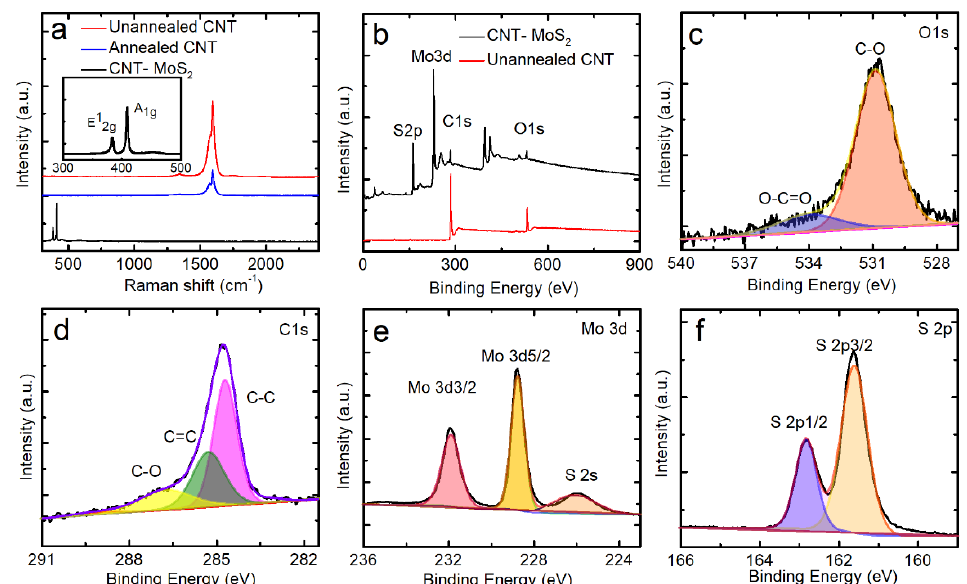
Figure 2. ( a ) Raman patterns of the unannealed and annealed CNT networks and CNT–MoS 2 composite network. ( b ) XPS survey of the unannealed CNT network and CNT–MoS 2 composite network, as well as the high ‐ resolution deconvoluted ( c ) O1s, ( d ) C1s, ( e ) Mo3d, and ( f ) S2p spectra of the CNT–MoS 2 composite network.